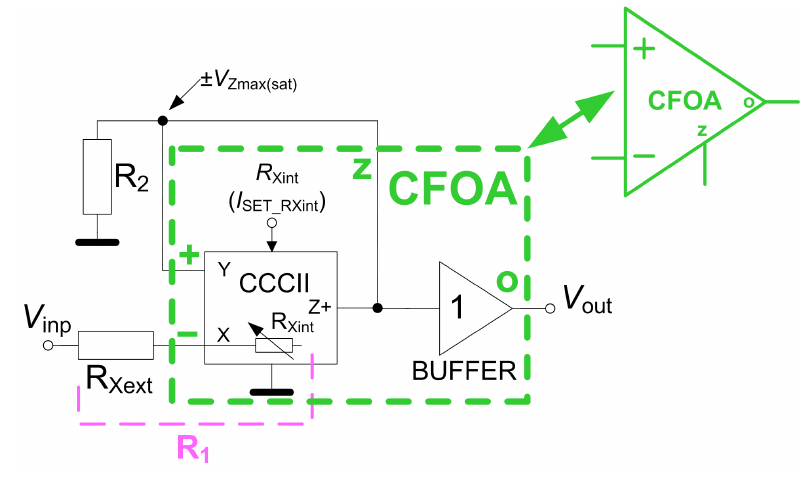
Figure 2. Principle of the proposed comparator.